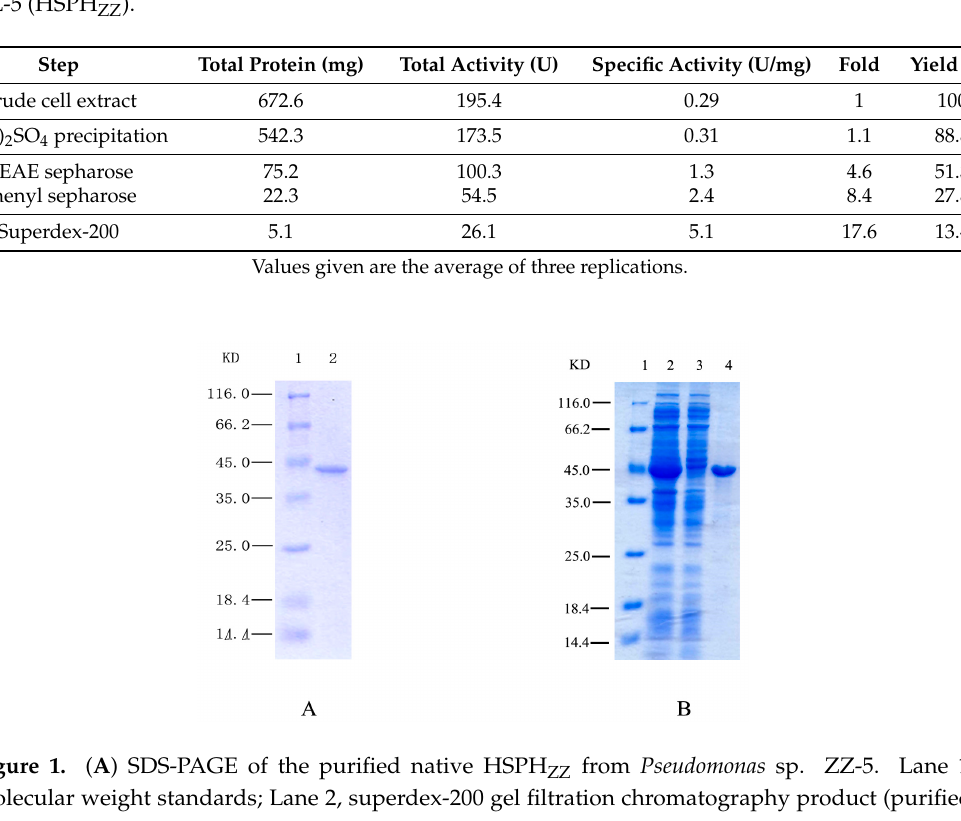
Table 1. Purification of a novel HSP (6-hydroxy-3-succinoylpyridine) hydroxylase from Pseudomonas sp. ZZ-5 (HSPH ZZ ).